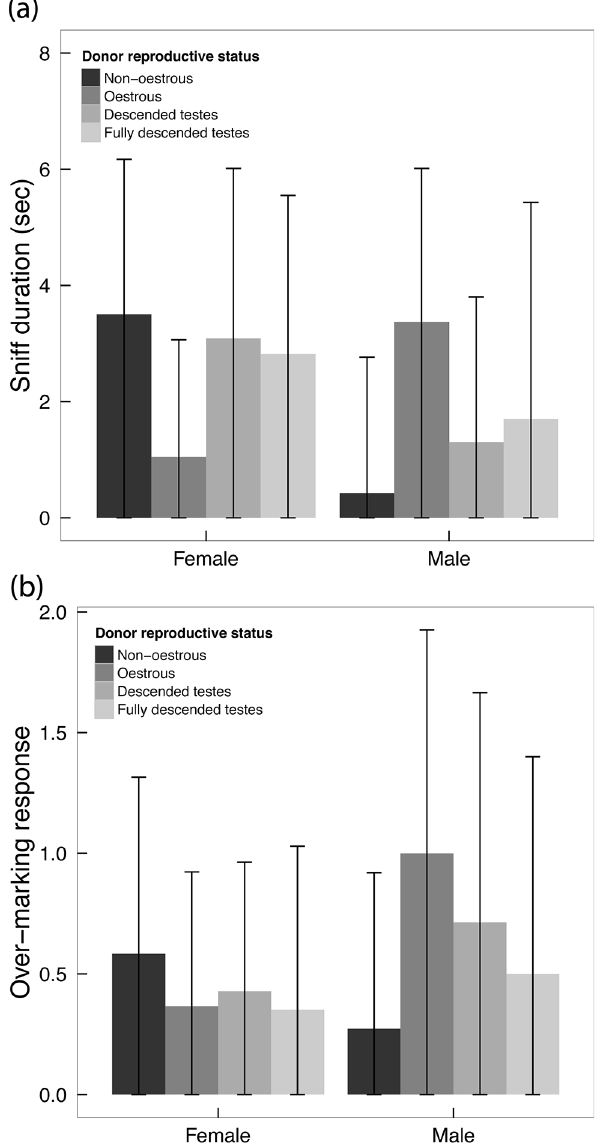
Fig 3. Variation in responses to AGS according to the reproductive status of the donor. Individual male and female ( ± SD) (a) duration of sniffing responses; and (b) number of subcaudal-marking responses per potential response to AGS in relation to the reproductive status of female (levels: oestrous, non-oestrous) and male (levels: descended testes, fully descended testes)